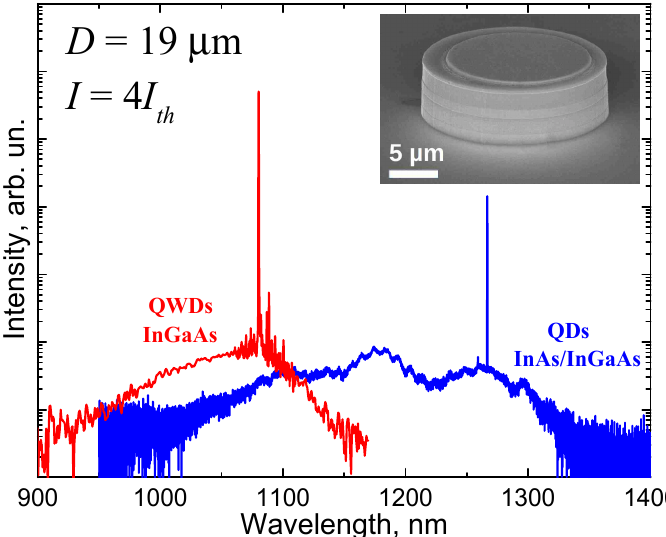
Figure 16. Lasing spectra of microdisk lasers based on (red) QWD and (blue) QD active area. The inset shows a microphotograph of the measured device.